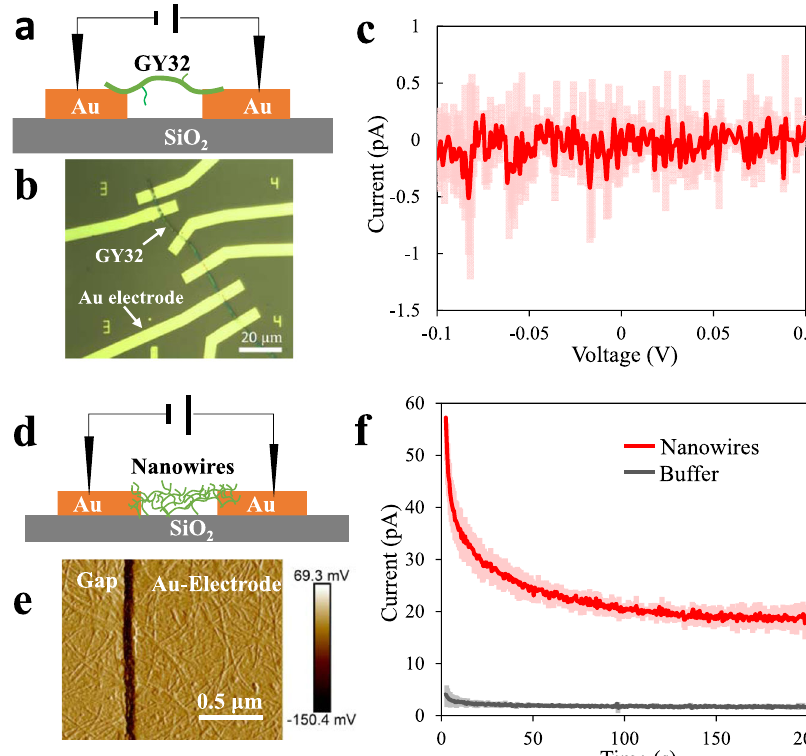
Fig. 4 Conductivity measurements of the GY32 cell envelope and nanowire-like appendages by microelectrodes. a Schematic of the single-cell measurement; b single cell on an electrode array observed under a light microscope; c current – voltage curve of a single GY32 cell ( n = 5, each from independent bacterial culture); d schematic of the appendage measurement; e appendage network on an electrode array observed by AFM, the dark line indicates a 100 nm height difference between the gap and electrode; f current – time curve of the hydrated appendage products (the voltage is 0.1 V, n = 8 independent bacterial cultures). Plots show mean and standard deviation. Source data are provided as a Source Data fi